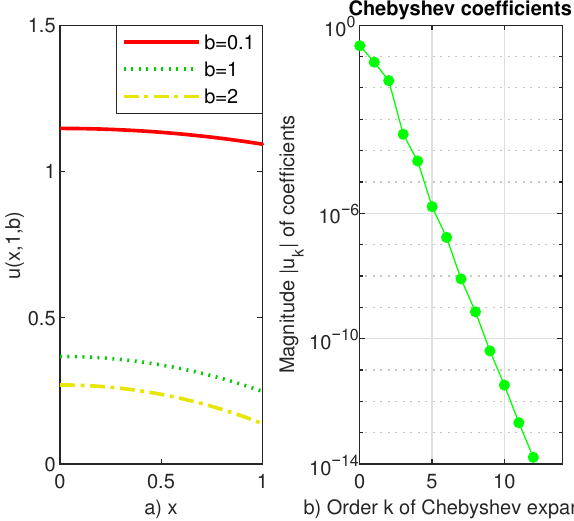
Figure 6. ( a ) Three solutions u ( x ,1, b ) to the problem (14). ( b ) This panel shows that when b : = 2 the Chebyshev coefficients of solution decrease almost linearly, close to the machine precision level, with a slope a little bit larger than −